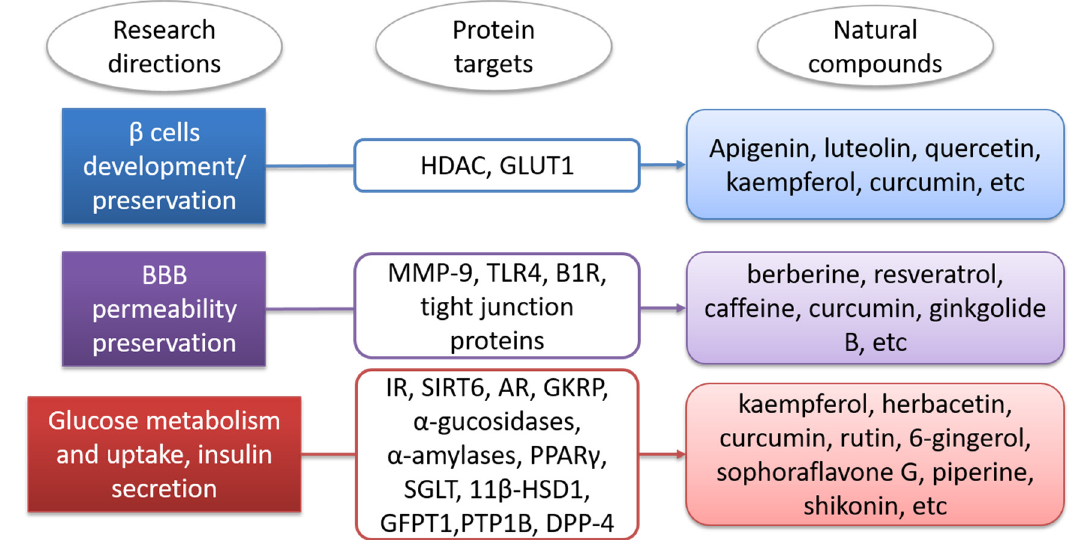
Figure 1. Research directions involving natural compounds for diabetes treatment. The protein targets associated with each direction, as well as some natural compounds that modulate their activities, are presented in the figure. The abbreviations of protein targets are: HDAC—histone deacetylases, GLUT1—glucose transporters 1, MMP-9—matrix metalloproteinases-9, TLR4—Toll-like receptors 4, B1R—bradykinin 1 receptors, IR—insulin receptors, SIRT6—mono-ADP ribo- syltransferase-sirtuin-6, AR—aldose reductases, GKRP—glucokinase regulatory proteins, PPAR γ —peroxisome prolifera- tor activated receptors gamma, SGLT—glucose co-transporters, 11 β -HSD1—11- β hydroxysteroid dehydrogenases type 1,